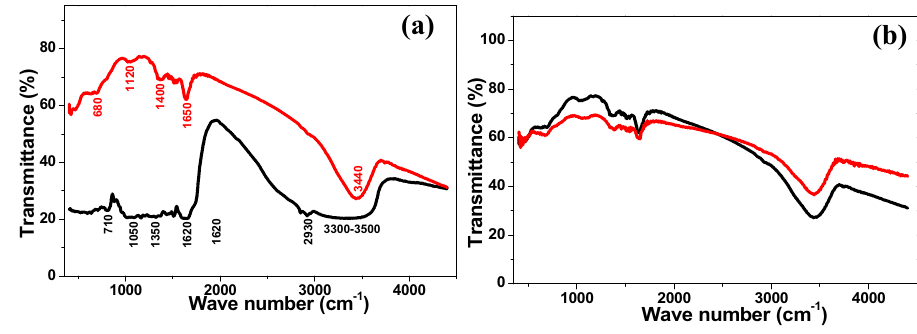
Fig. 6 a FTIR spectra obtained for Et-ACPE (black) and Et- AgNPs (red); b FTIR spectra obtained for pure Et-AgNPs (black) and surface adsorbed Et-AgNPs (red) on X80 steel